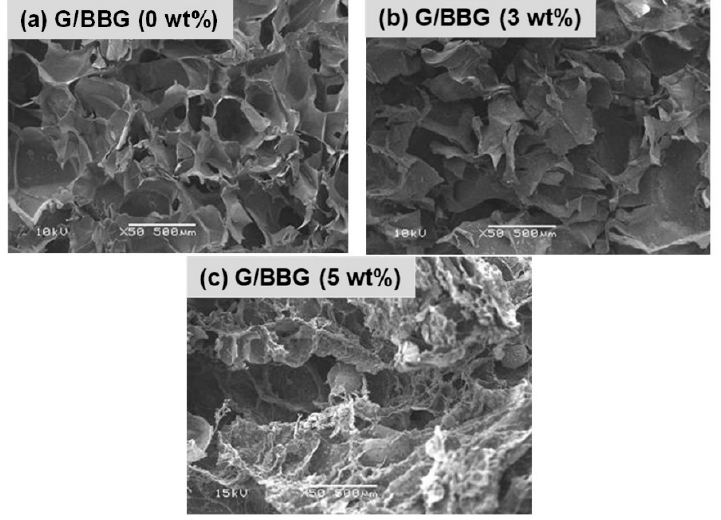
Figure 5. SEM micrographs of the ( a ) G/0 BBG, ( b ) G/3 BBG, ( c ) G/5 BBG nanocomposite hydrogels loaded with different contents of BBG nanoparticles.